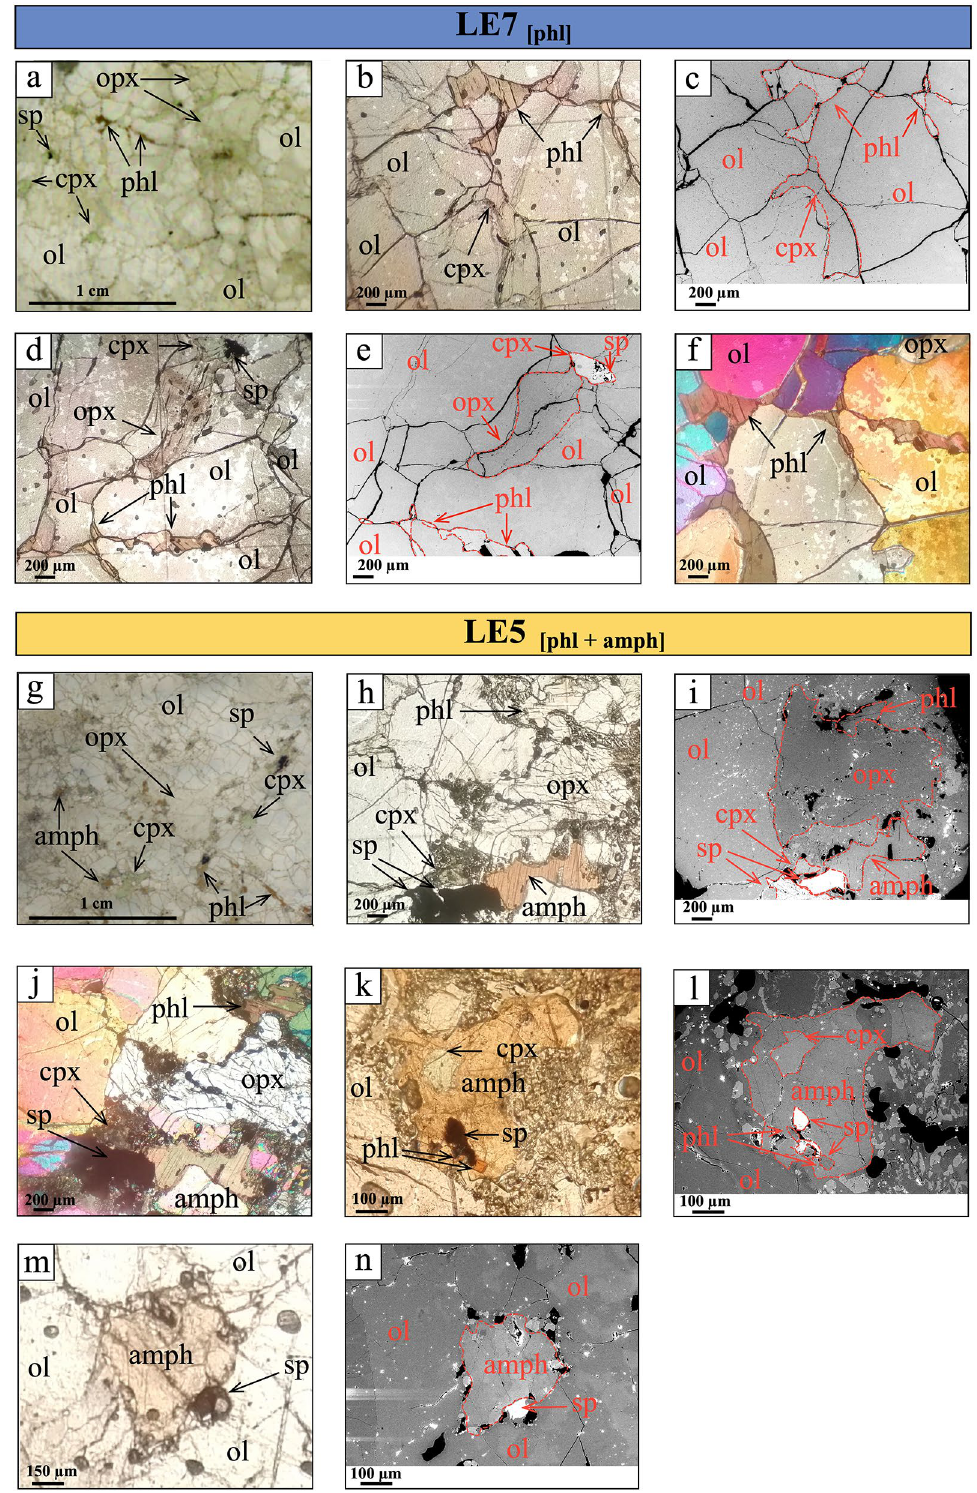
Figure 1. Thin sections images under optical microscope, plane- and cross-polarized transmitted light, and scanning electron microscope in backscattered electron mode (BSE) of Mount Leura peridotite sample LE7 [phl] ( a, b, c, d, e, f ) and sample LE5 [phl+amph] ( g, h, i, j, k, l, m, n ). ( a ) thin section of LE7 [phl] showing the harzburgite mineral assemblage with phlogopite (phl). b, c, d, e, f phl micrograins showing textural equilibrium with clinopyroxene (cpx), olivine (ol) and orthopyroxene (opx) in sample LE7 [phl] . a, b, d plane pol. light; c , e BSE images; f cross pol. light. g thin section of LE5 [phl+amph] showing the harzburgite mineral assemblage with phl and amphibole (amph). h, i, j, k, l, m, n microphotographs showing different aspects of the textural relationships between mineral phases, including amphibole and phlogopite. k displays a phlogopite micrograin included in a larger amphibole grain. The latter, with corroded borders, is set in a reaction zone. A cpx micrograin, with corroded edges, is enclosed in the amphibole. i, l, n show bright oxides and sulfides included in minerals. g, h, k, m plane pol. light; i, l, n BSE images; j cross pol.